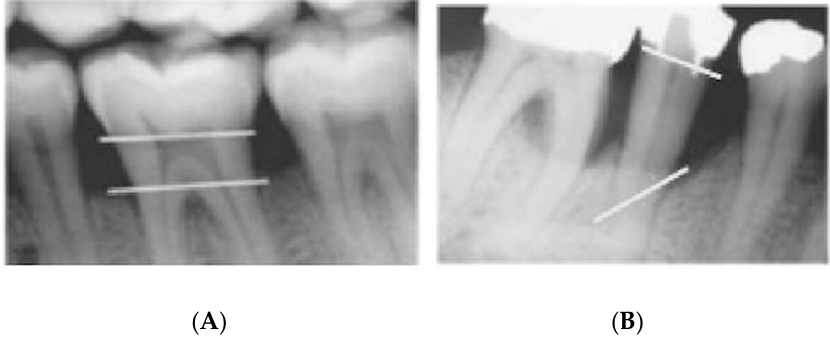
Figure 2. Visual interpretation of bone loss severity. The ‘worst’ tooth in each quintet is visually divided into coronal, middle, and apical thirds and the percentage of alveolar bone loss is measured accordingly.